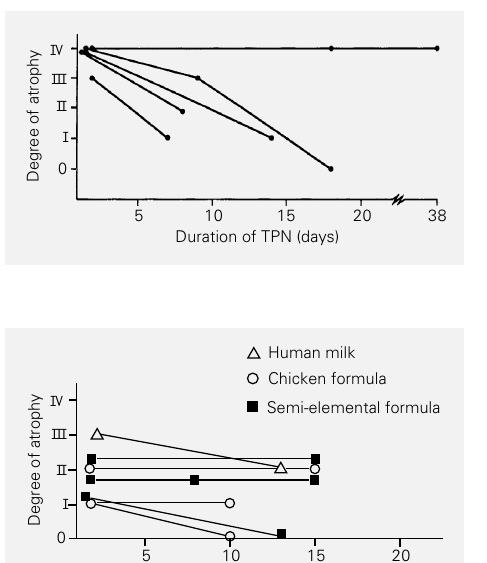
Figure 1 - Evolution of jejunal mucosal morphology in 5 in- fants with protracted diarrhea submitted to total parenteral nu- trition (TPN).